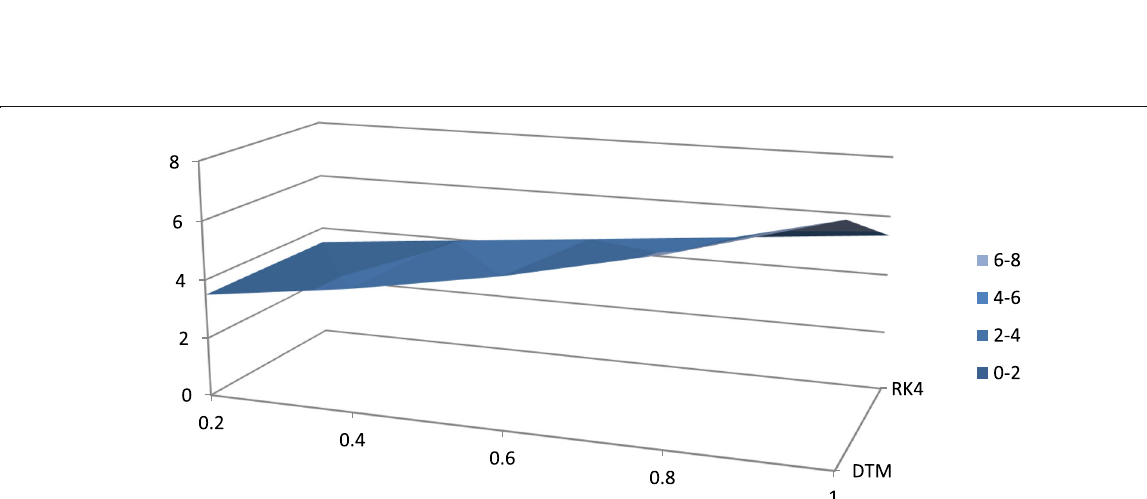
Fig. 14 Description of the sub-population of exposed individuals who are latently infected